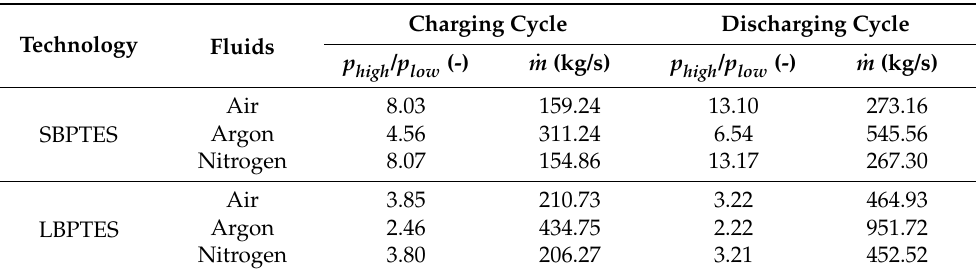
Table 4. Operating conditions of LBPTES and SBPTES systems for different operating fluids. The results are related to the nominal power rating of 50 MW and a charging duration of 8 h. For LBPTES, the results refer to a configuration with η rt ≈ 0.58.